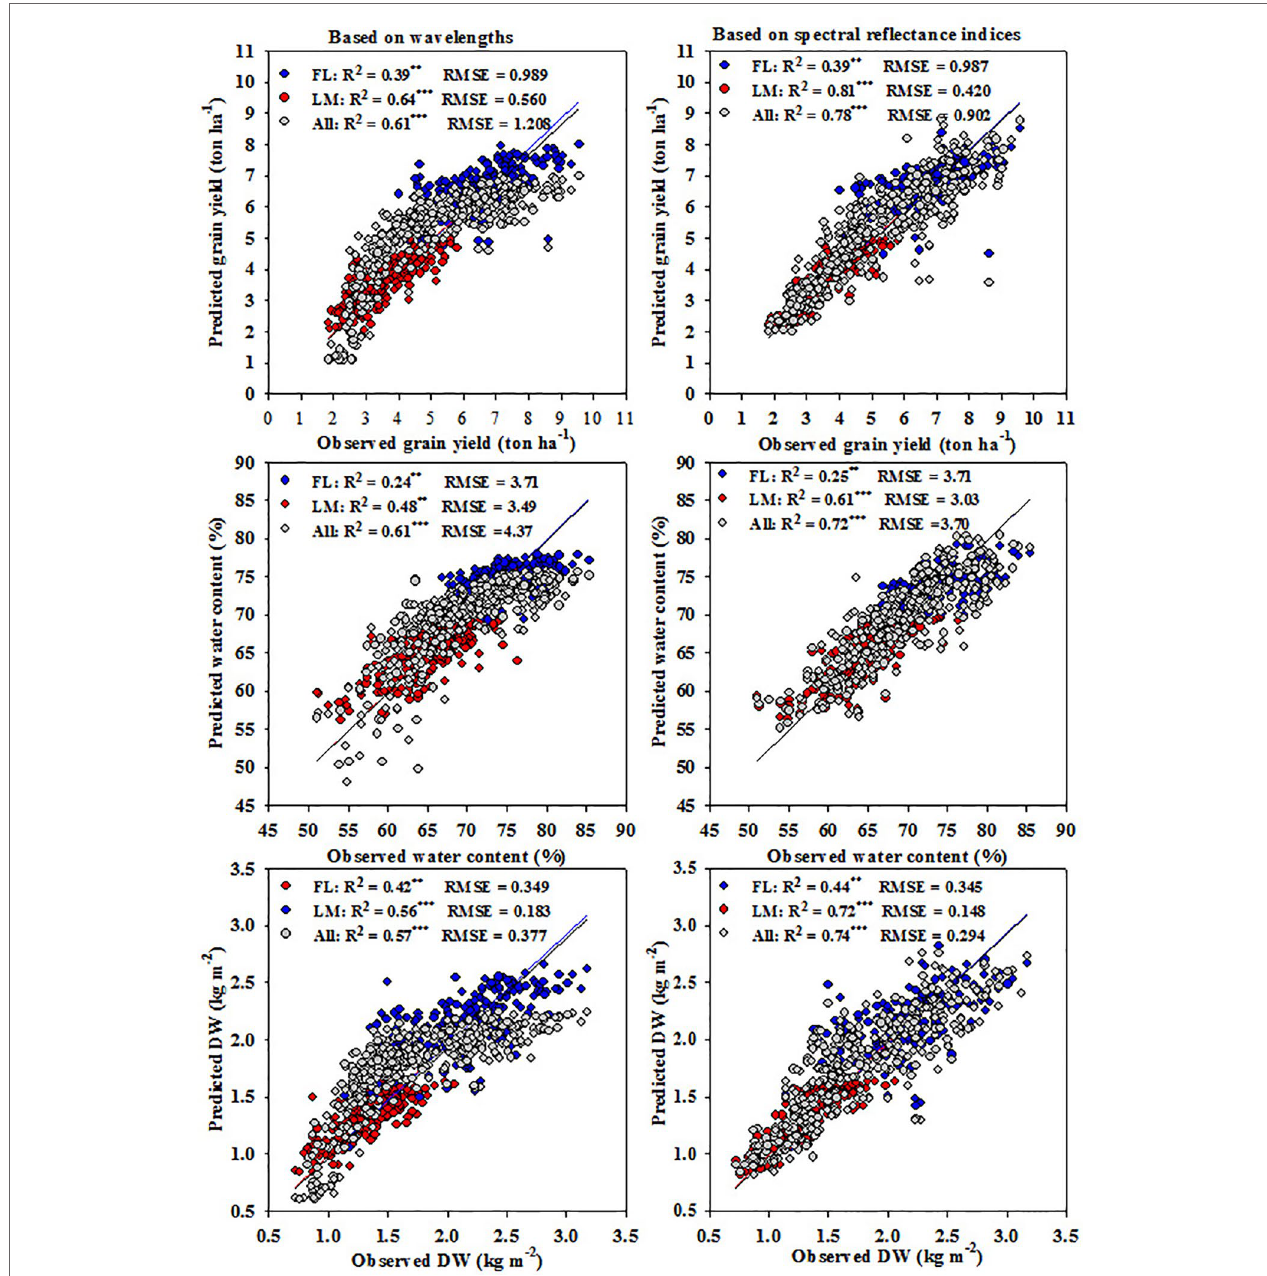
FIgURe 6 | Relationship between estimated and observed measured parameters ((shoot dry weight per square meter (DW), water content of aboveground biomass (WC), and grain yield per hectare (GY)) under full irrigation (FL), limited irrigation (LM), and the combined two treatments (All) based on influential wavelengths or SRIs.